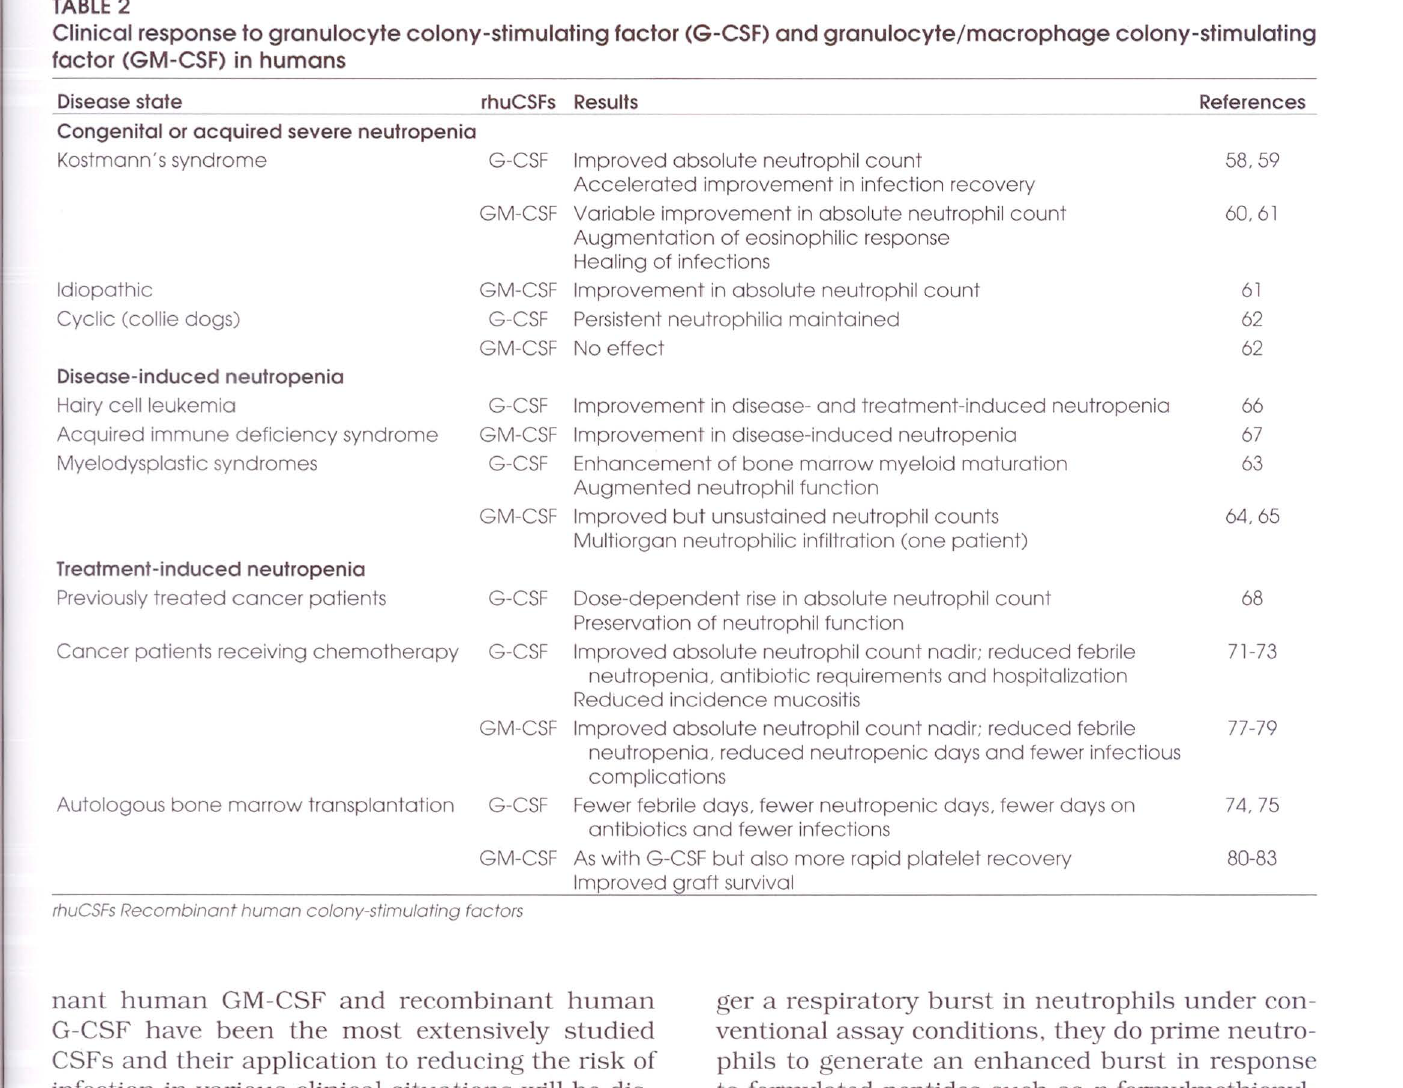
Clinical response to granulocyte colony-stimulating factor (G-CSF) and granulocyte/macrophage colony-stimulating factor (GM-CSF) in humans Disease